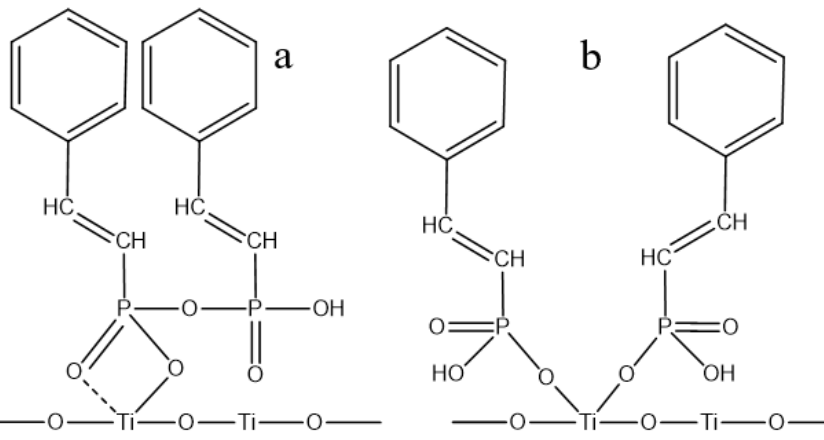
Figure 9. The conjecture of a Ti atom adsorption of two SPA molecular models: ( a ) two SPA molecules to form polymerization; ( b ) two SPA molecules are combined with TiO 2 .